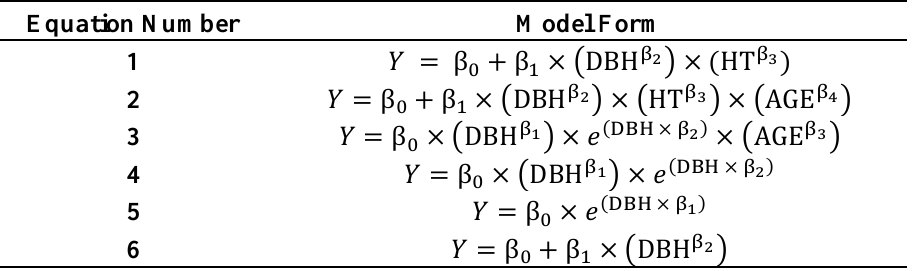
Table 2. List of prediction equation model